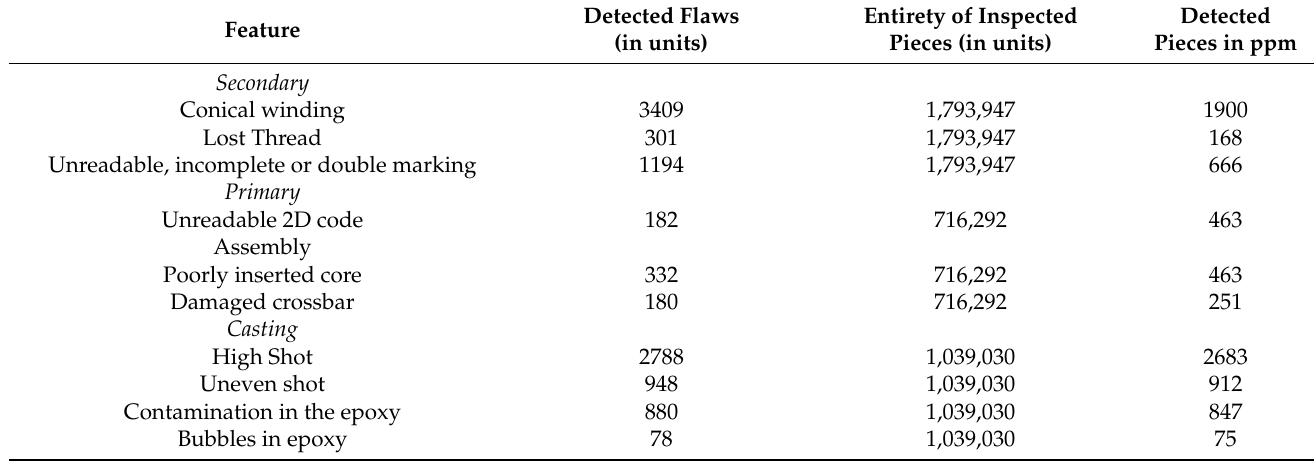
Table 5. Number of occurrences of potential failure modes with a subjective character in the visual inspection process.